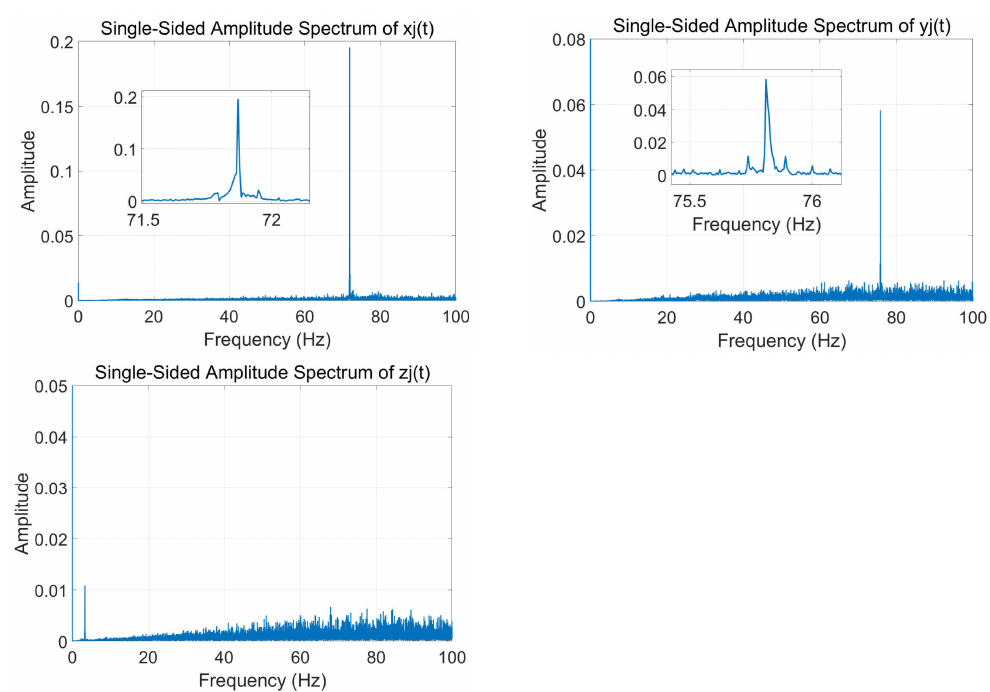
Figure 5. Spectrum analysis diagram of the three-axis accelerometer in the static environment.